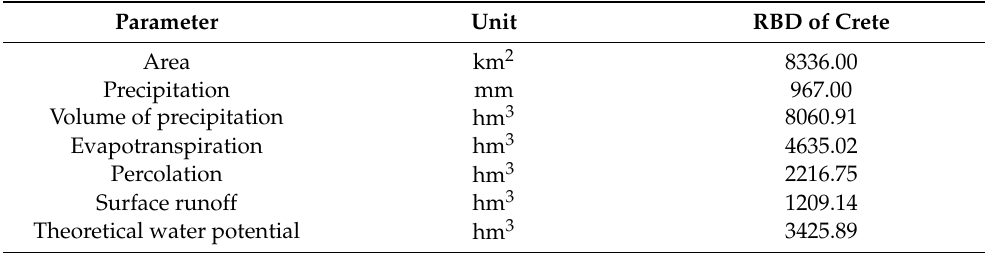
Table 3. General hydrological data (annual average values of a normal year) for the river basin districts (RBDs) of the island of Crete.